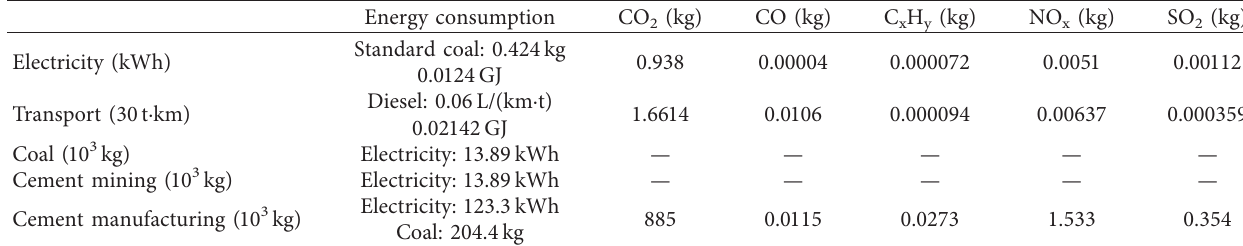
Table 6: Environmental data for utility systems and cement production.